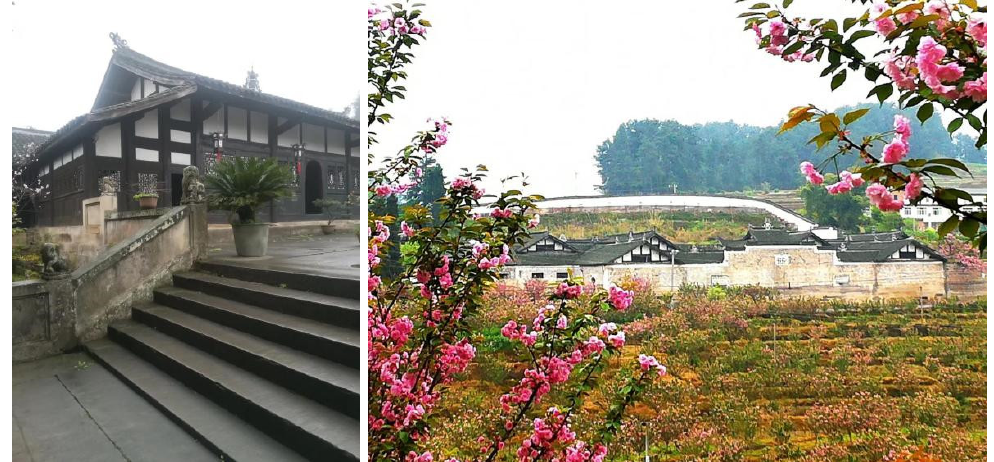
Figure 9. The Chen manors with traditional Chongqing residential style (source: Taken by the author).